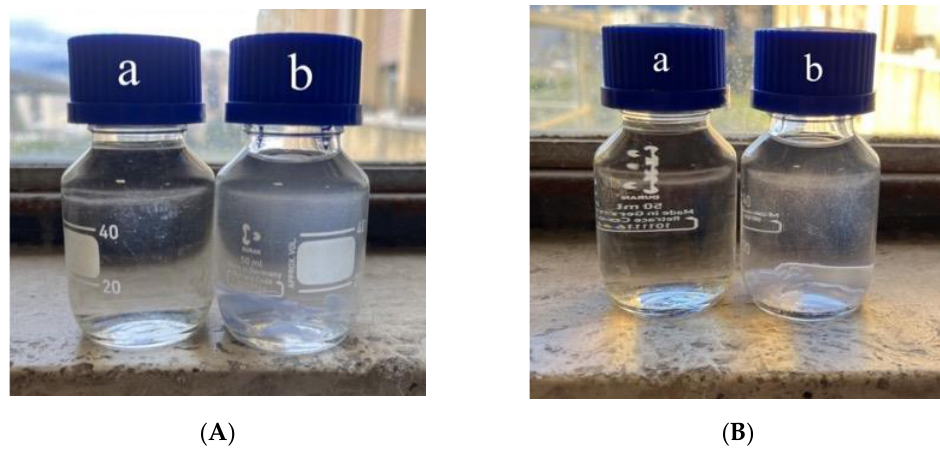
Figure 13. Photos of the solutions PS/PET: ( A ) PS/PET_1: (a) solvent, (b) suspensions; ( B ) PS/PET_5: (a) solvent, (b) suspension.